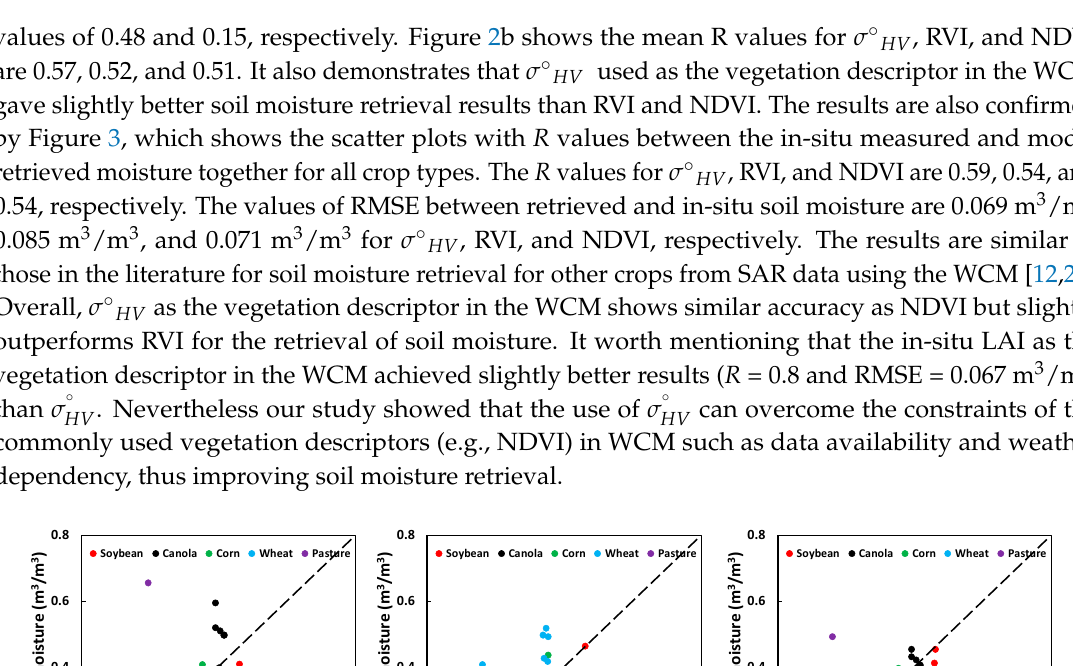
Figure 4. The plots of LAI against three vegetation descriptors: σ ° HV (top row), RVI (middle row) and NDVI (bottom row) for each crop type.